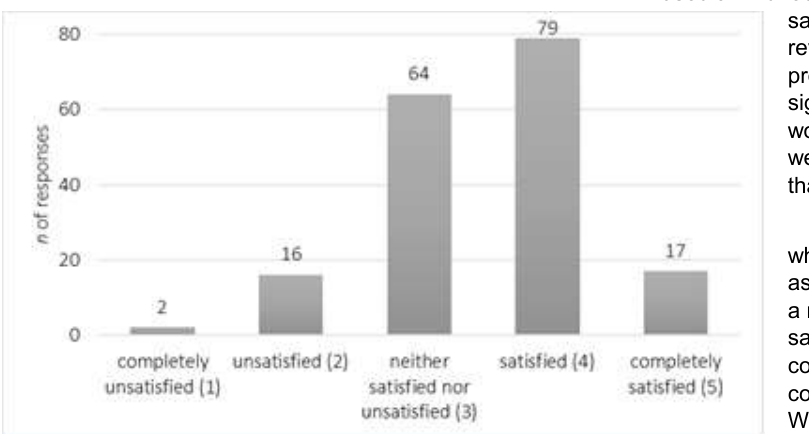
SLPs’ Level of Satisfaction with Telepractice in General (n=178)